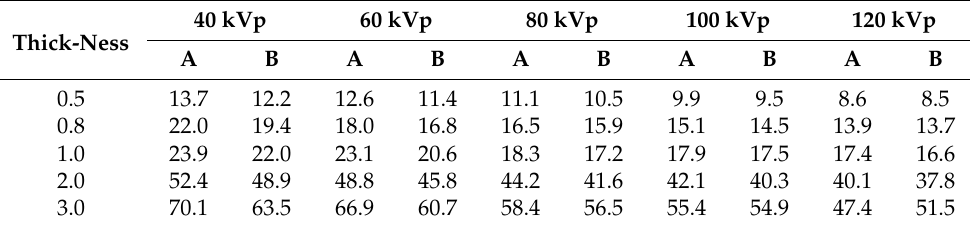
Table 1. Comparison of shielding performance by energy according to shielding material